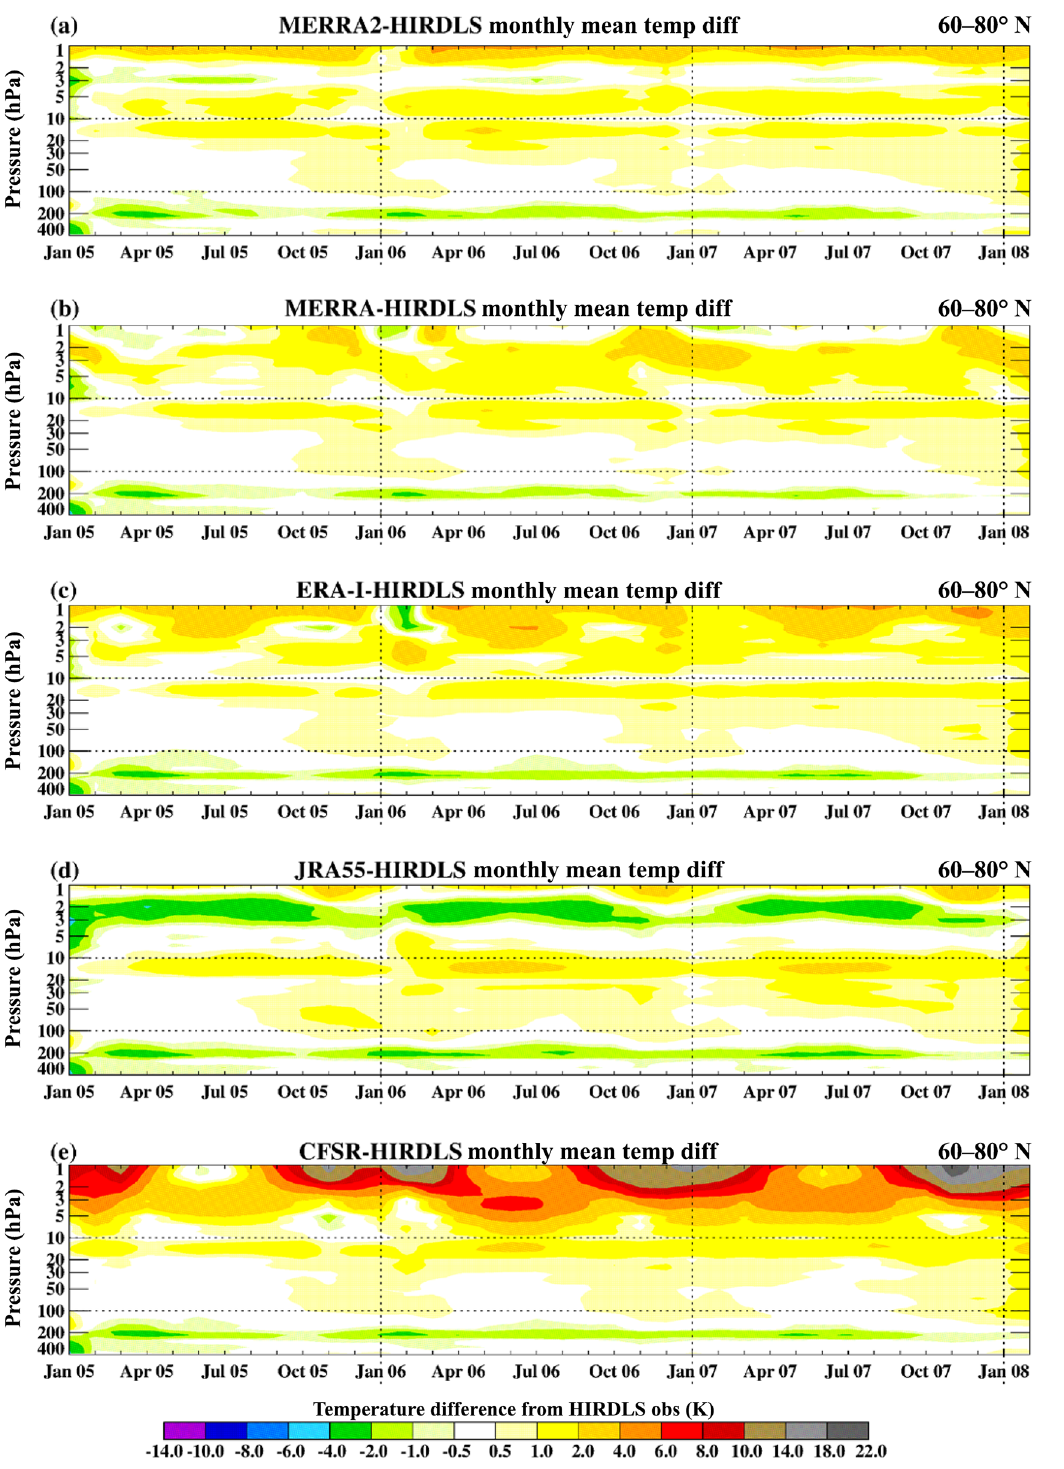
Figure 13. Same as Fig. 12 except for the Northern Hemisphere high-latitude zone (60–80 ◦ N).